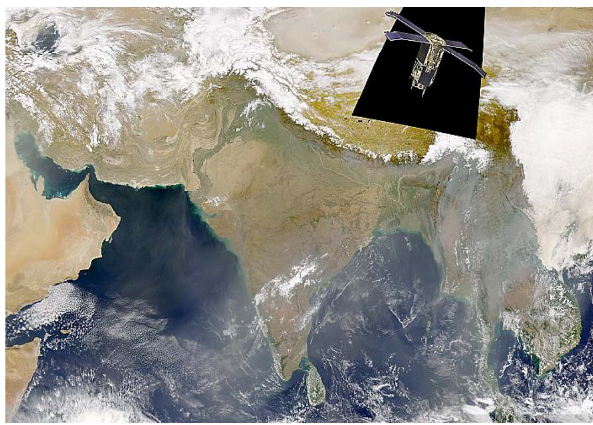
Fig. 8. Trajectories of 17 constant-level balloons launched from Goa, India, during INDOEX (January–March 1999) at pressure lev- els between about 900 and 800hPa (from Eth´e et al., 2002, copy- right 2002 by the American Geophysical Union, reproduced with permission; the data are also presented in Appu et al., 2001).